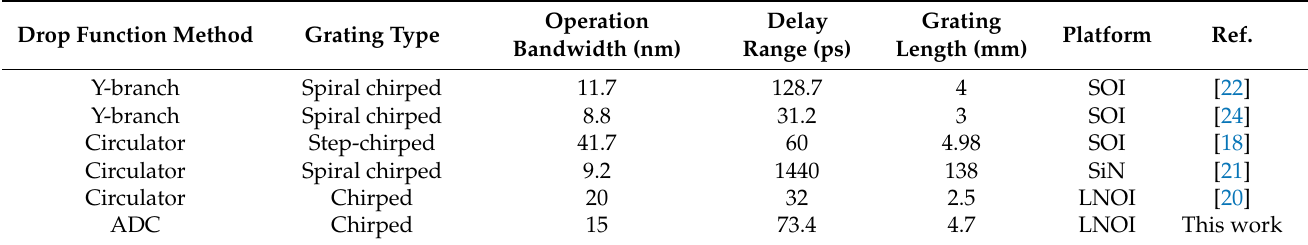
Table 1. Comparison of reported integrated chirped Bragg